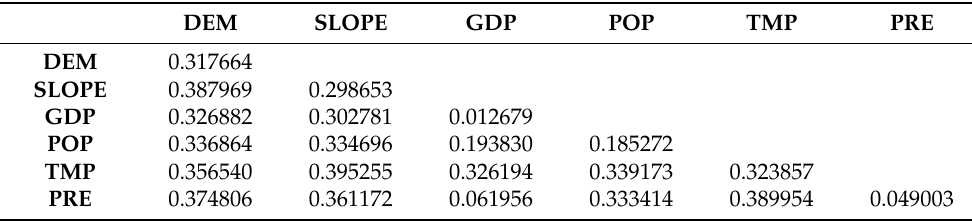
Table A12. The force (q-value) among any two influencing factors on Splitting Index (SPLIT) interac- tively in